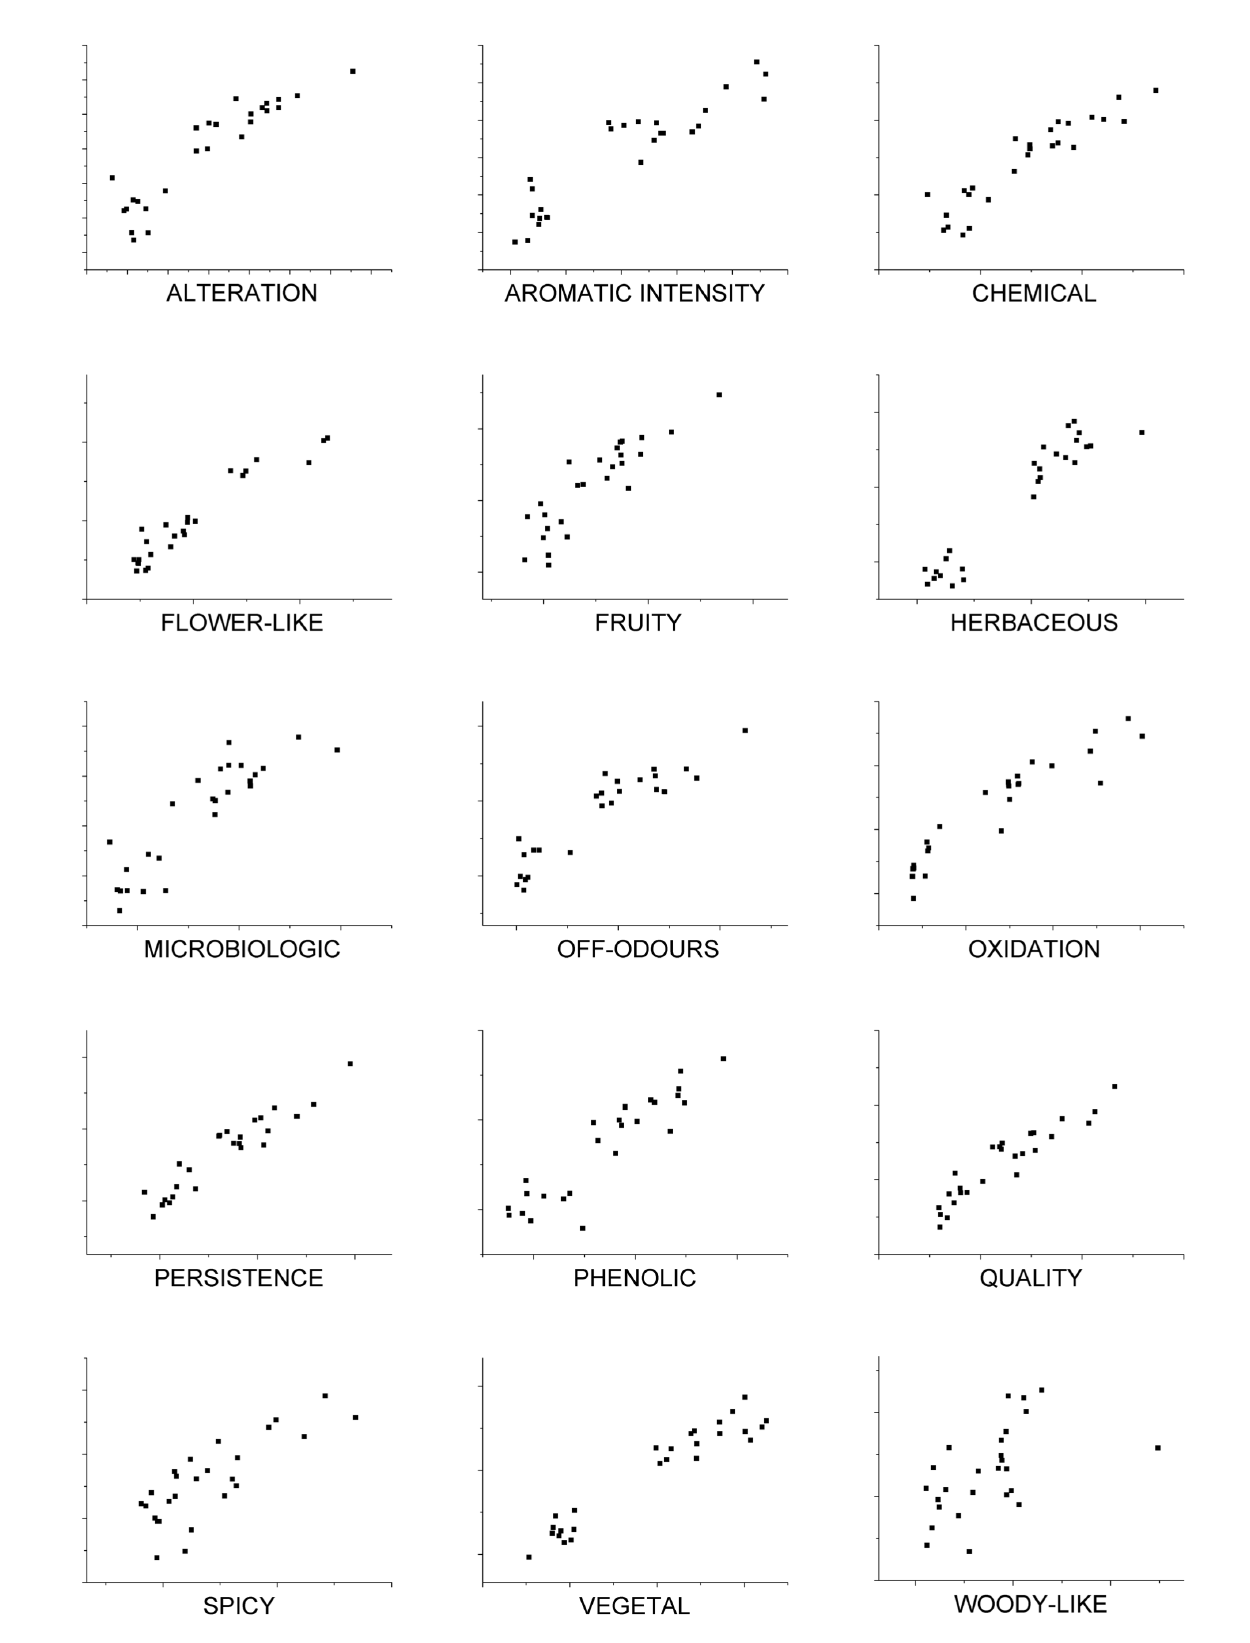
Figure 10. Sensory panel attributes estimated by PLS model (y) vs . real values